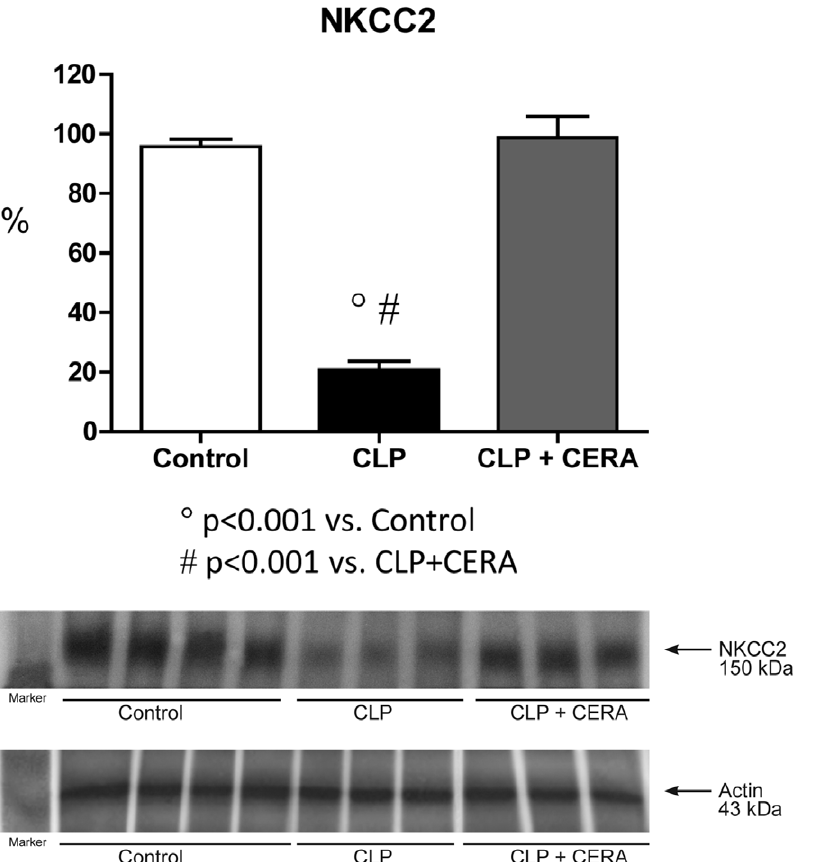
Figure 1. Immunoblots for renal Na-K-2Cl cotransporter, revealing a 146- to 176-kDa band (centered at 150 kDa). Semiquantitative immunoblots prepared from kidney samples. Densitometric analysis of all samples from control rats, rats submitted to cecal ligation and puncture only, and rats treated with continuous erythropoietin receptor activator prior to undergoing cecal ligation and puncture. Differences among the means were analyzed by analysis of variance followed by the Student-Newman-Keuls test. P . 0.05 for control vs. CLP + CERA. CLP, cecal ligation and puncture; CERA, continuous erythropoietin receptor activator; NKCC2, renal Na-K-2Cl cotransporter.